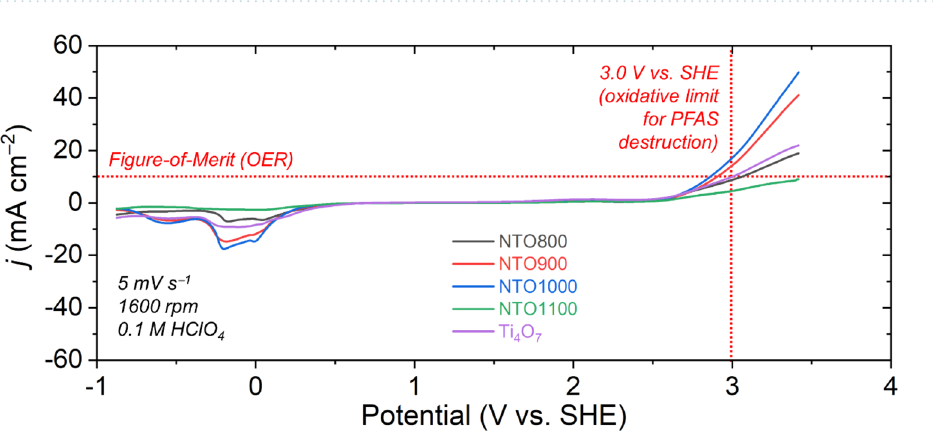
Figure 5. Electrochemical stability window of Ti 4 O 7 , and this series of NTO (NTO800, NTO900, NTO1000, and NTO1100) cycled with an imposed scan rate of 5 mV s –1 , with a rotation speed of 1600 rpm, in a 0.1 M HClO 4 supporting electrolyte. 3.0 V vs. SHE corresponds to the upper oxidative stability limit for EAOP electrodes. All electrochemical potentials were iR compensated for the uncompensated resistance, as determined by measuring impedance at the open circuit